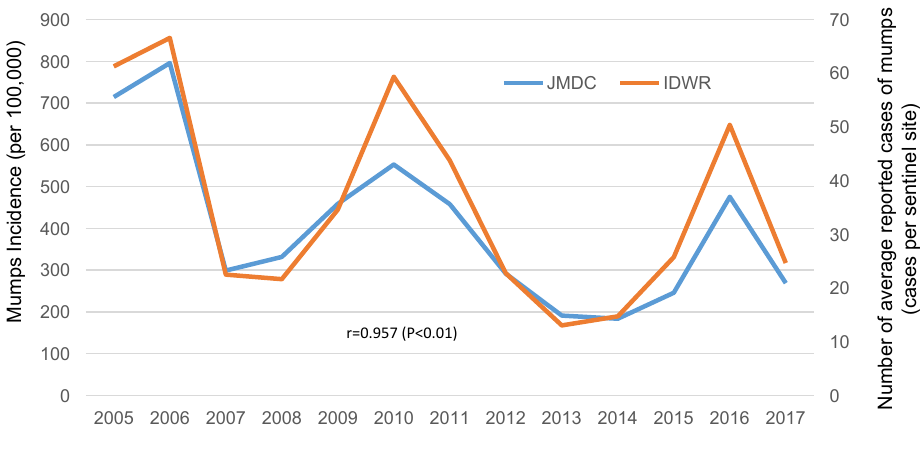
Figure 1. Mumps incidence ( / 100,000 persons: JMDC) and number of average reported cases of mumps per sentinel site (IDWR 3